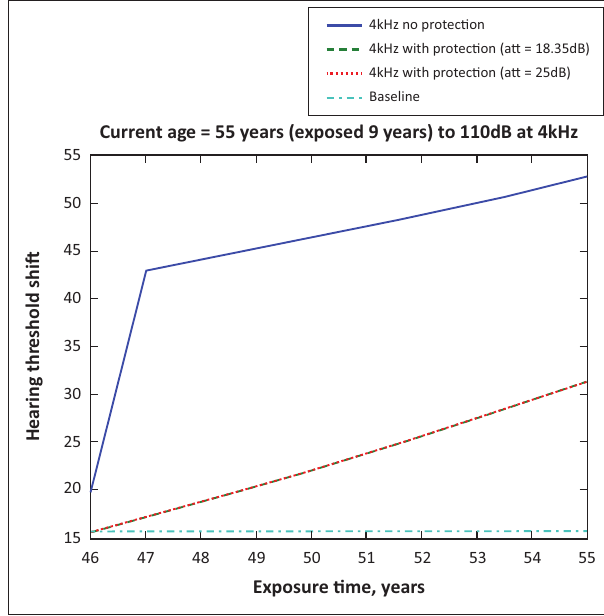
Source : Figure created using data from Moroe, N.F. (2018). Occupational noise-induced hearing loss in South African large scale mines: From policy formulation to implementation and monitoring . Doctoral thesis. Johannesburg: University of the Witwatersrand. FIGURE 8: Thirty-eight years old at 3000 Hz with exposure levels of 107 dB.